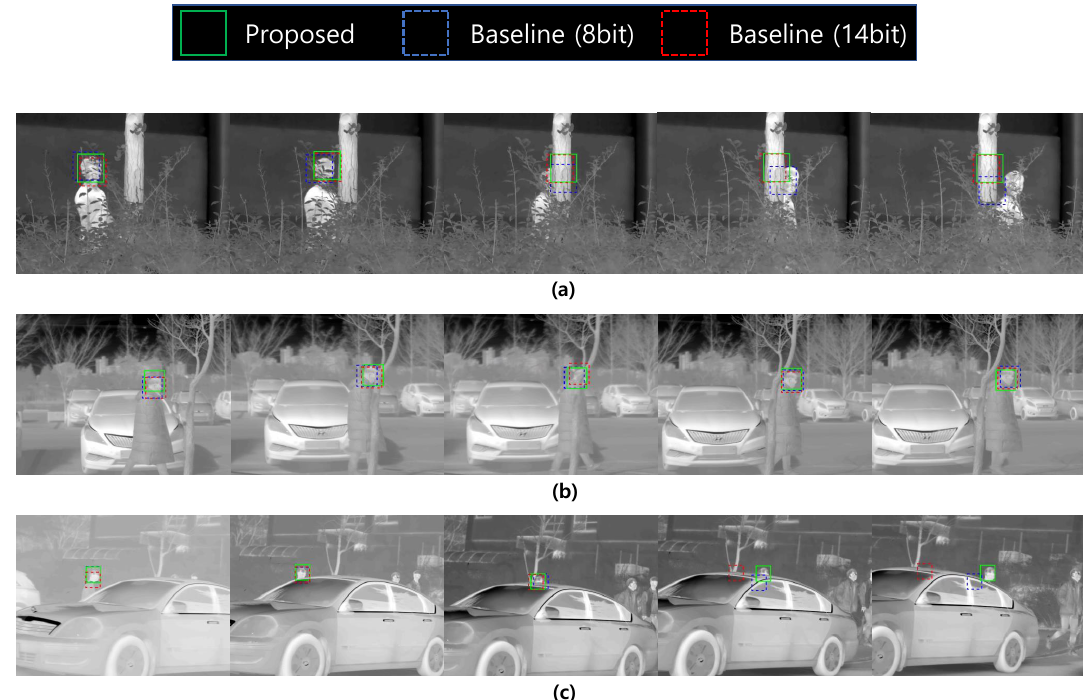
Figure 14. Tracking performance of brightness, 14-bit DC, and proposed in occlusion scenario: ( a ) complete occlusion, ( b ) and ( c ) partial